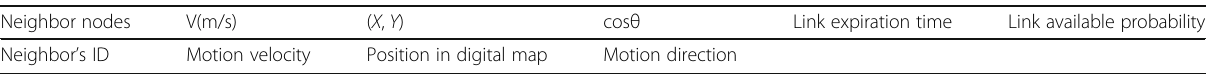
Table 3 Neighbor table Neighbor